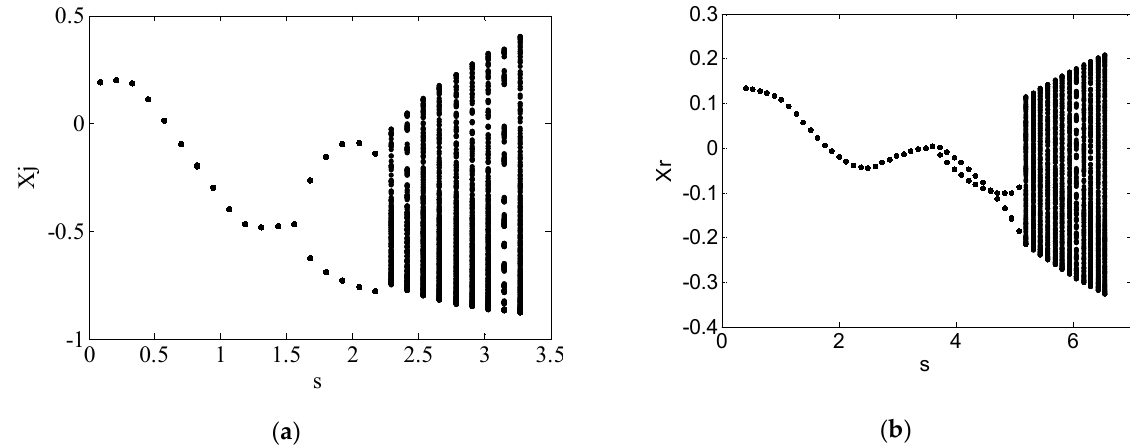
Figure 3. Bifurcation diagram of the axis and floating ring when λ = 0.01: ( a ) bifurcation diagram of journal; ( b ) bifurcation diagram of floating ring.